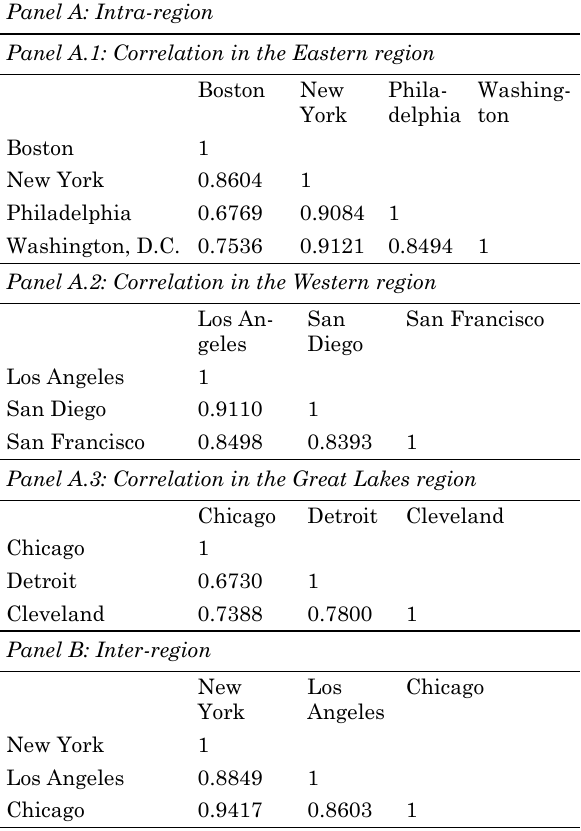
Table 3. Pearson correlation coefficients of house price index in each region Panel A: Intra-region Panel A.1: Correlation in the Eastern region